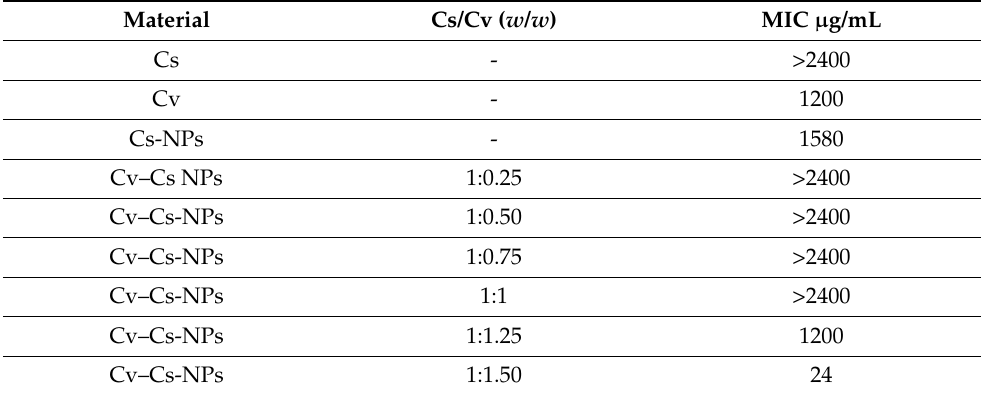
Table 1. Antimicrobial activities of NPs obtained with different Cs/Cv loaded in Cs-NPs C. albicans against AIDS